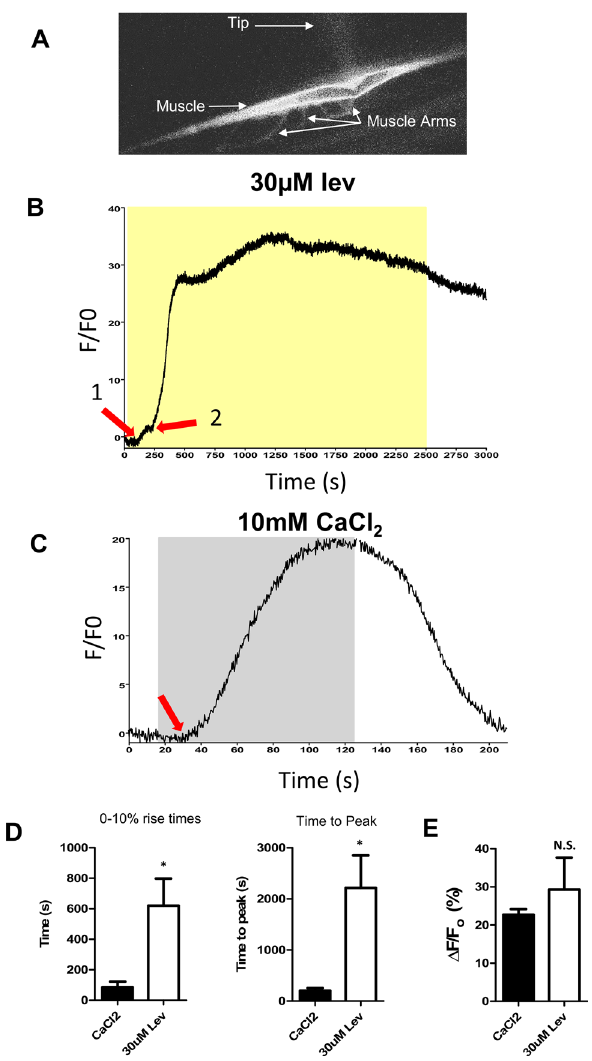
Figure 2. Long-term levamisole application generates a calcium response in Brugia malayi muscles injected with Fluo-3. ( A ) Picture of muscle cell taken illustrating fluorescence after injection of 5 µM Fluo-3. The patch-pipetted is just visible (Tip). The muscle arms are shown as is the strap-like muscle. ( B ) Representative trace of a calcium signal in response to long-term application of 30 µM Levamisole. Arrow 1 represents the first initial increase in the calcium signal. Arrow 2 indicates the second, much larger increase. Yellow box indicates levamisole application. ( C ) Representative response to 10 mM CaCl 2 . Arrow represents the initiation of the response. Grey box represents stimulus application. ( D ) Quantification of the average time taken for the calcium signal to reach 10% of the overall amplitude in response to 10 mM CaCl 2 (black bar) and 30 µM levamisole (White bar). *Significantly different to CaCl 2 (CaCl 2 vs lev p ≤ 0.0181, t = 2.961, df = 8, unpaired t-test). Quantification of the average time for the calcium signal to reach peak (100%) in response to 10 mM CaCl 2 (Black bar) and 30 µM levamisole (White bar). *Significantly different to CaCl 2 (CaCl 2 vs Lev p ≤ 0.0134, t = 3.160, df = 8, unpaired t-test. ( E ) Amplitudes of Ca 2+ signals in the muscle in response to 10 mM CaCl 2 (Black bar) and 30 µM levamisole (White bar). N.S. not significantly different to CaCl 2 (CaCl 2 vs Lev p = 0.4622, t = 0.7723, df = 8, unpaired t-test). All values represented as mean ± SEM. CaCl 2 recordings n = 5 muscles from 5 individual worms. Levamisole recordings n = 5 muscles from 5 individual